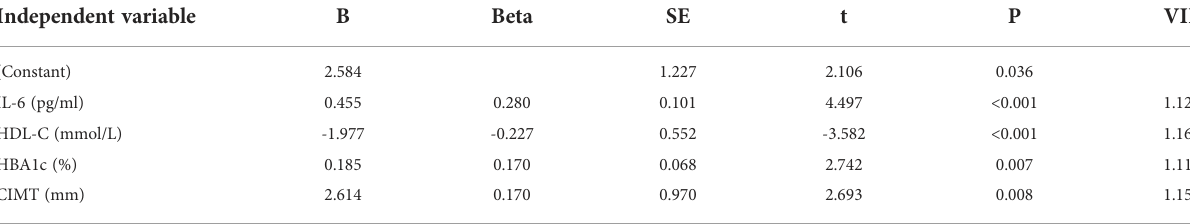
TABLE 4 Stepwise multiple linear regression analysis with GRB2 as the dependent variable.